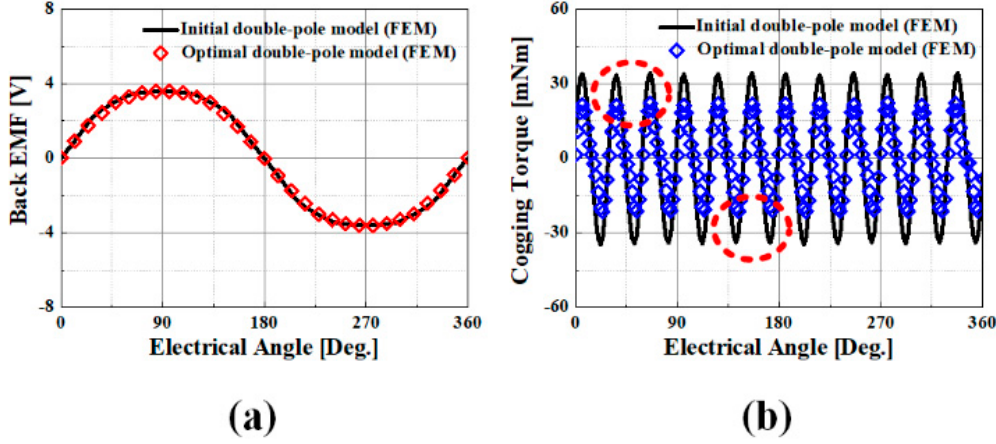
Figure 8. Experimental and analysis results of the single-pole model: ( a ) Back EMF and ( b ) cog-